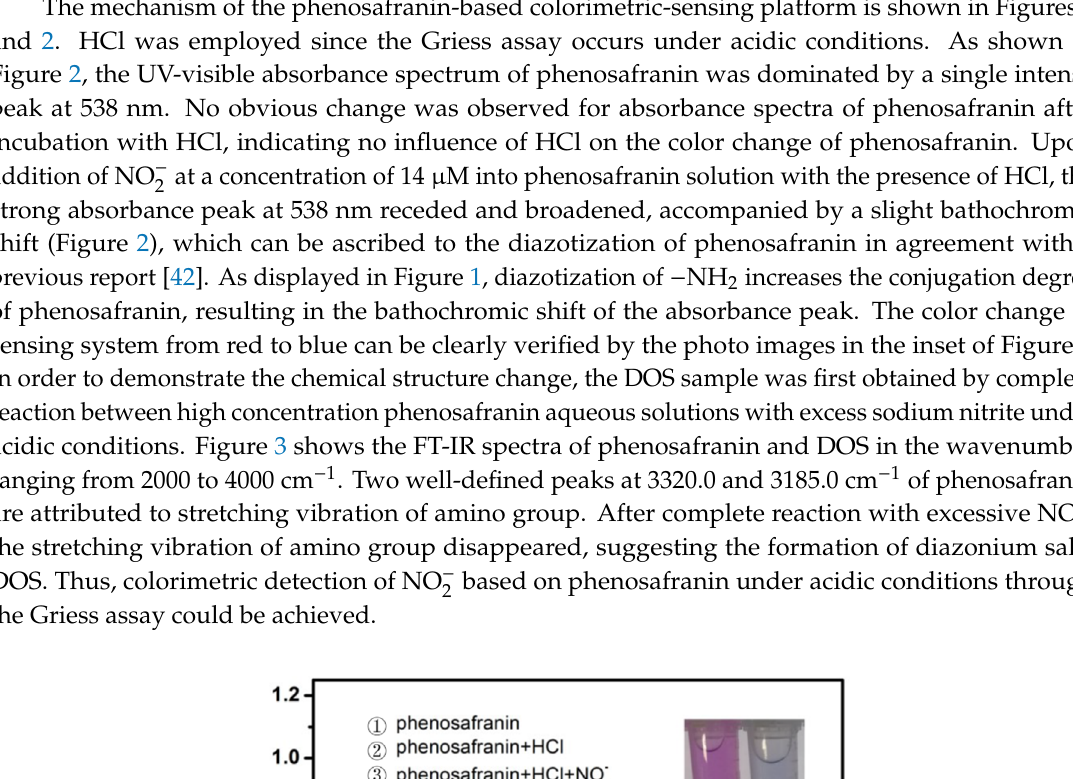
Figure 2. UV-visible spectra of phenosafranin (0.25 mM) before and after incubation with NO (cid:2870)(cid:2879) (10 μM) under acidic condition (HCl of 0.4 M) (inset: corresponding photo image with (right) and without (left) NO (cid:2870)(cid:2879) ).